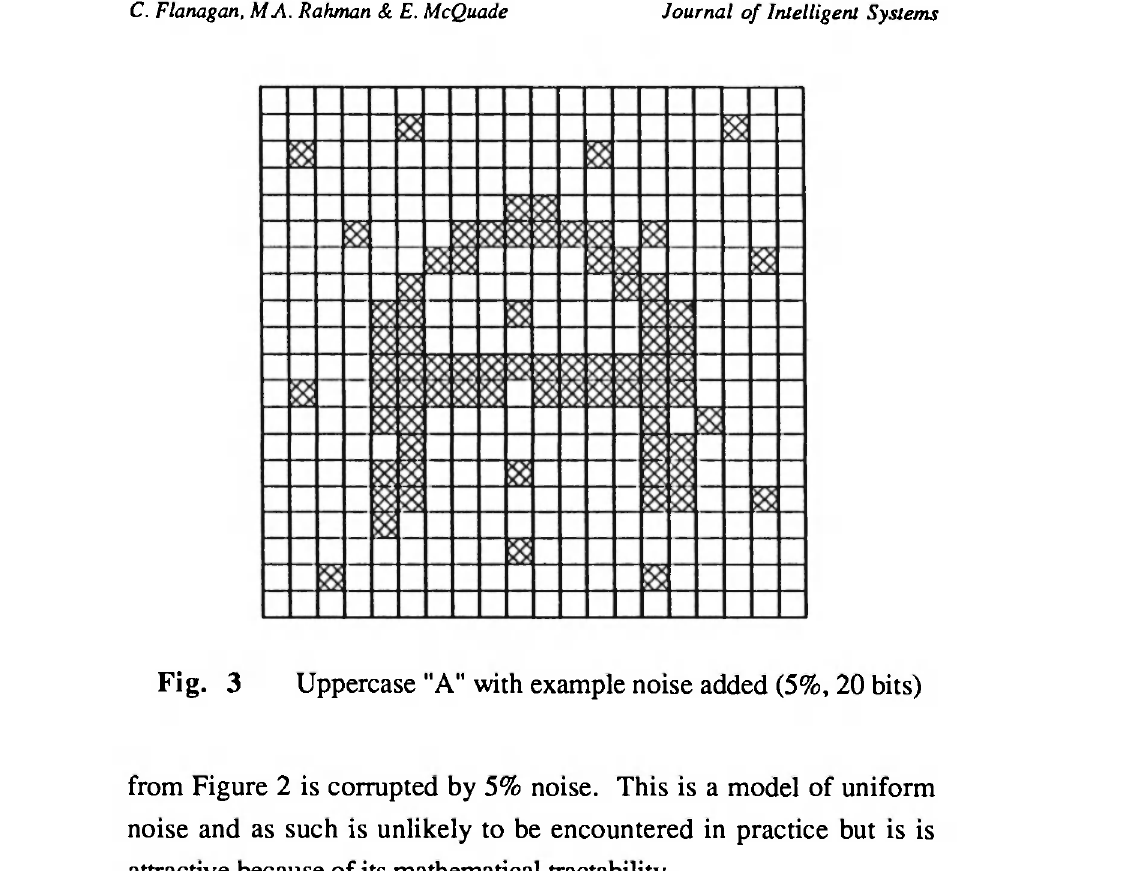
Figure 4 records the results of this first experiment. What